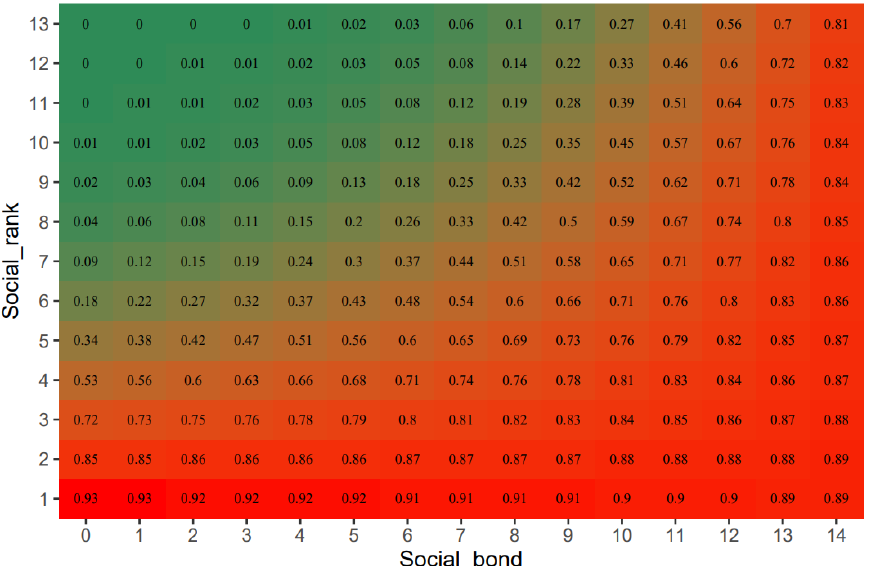
Figure 3. A heat map of member scores for the interaction between social rank and social bond. The values in the heat map represent the probability of coalition success: the closer the color is to red (the heat map score is up to 1), the greater the possibility of a successful coalition, and the closer is to green (the lowest scores is 0), the greater the possibility of failure.